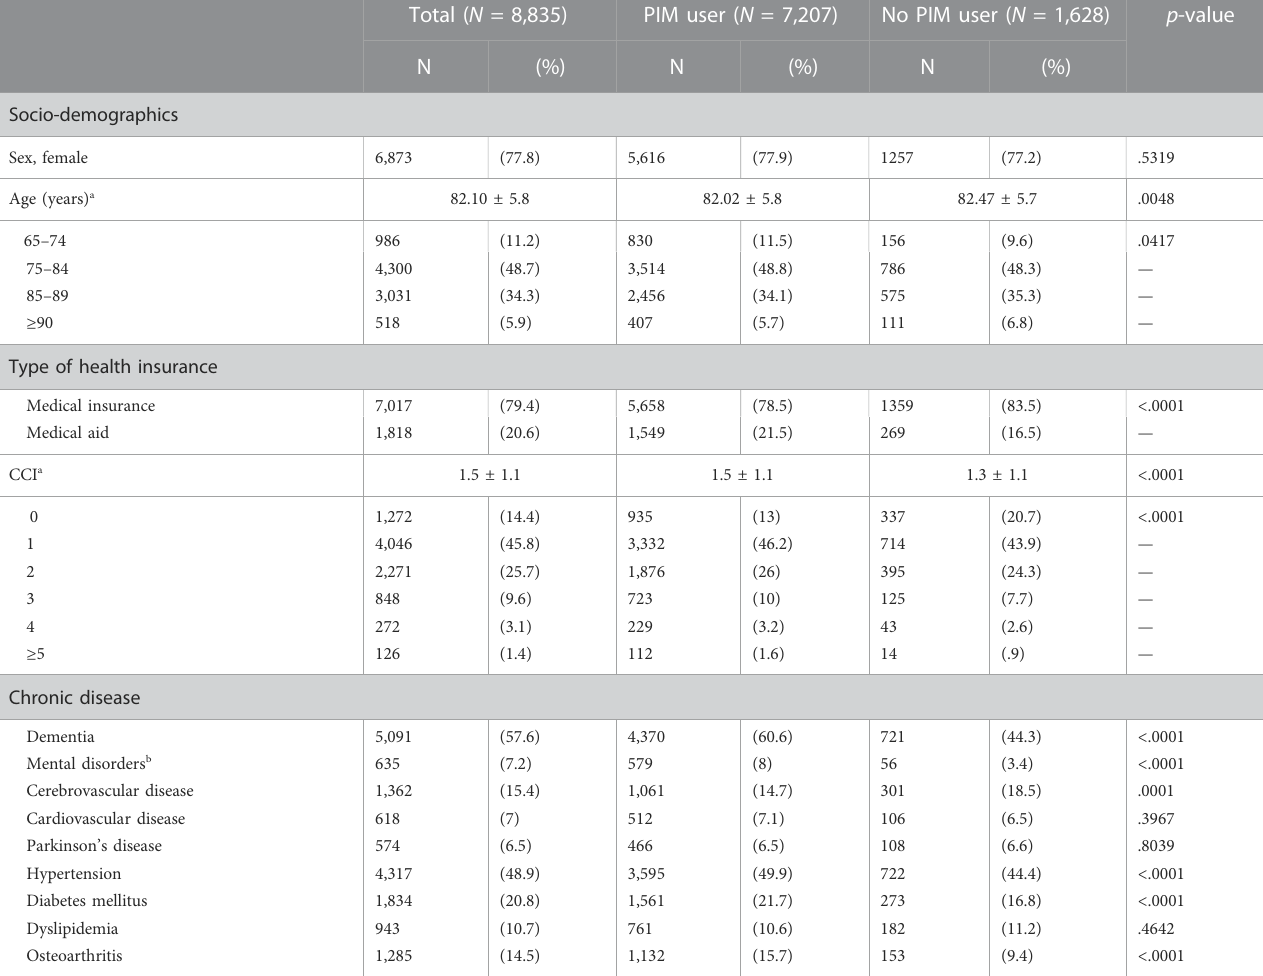
TABLE 1 Baseline characteristics of included long – term care facility residents in this